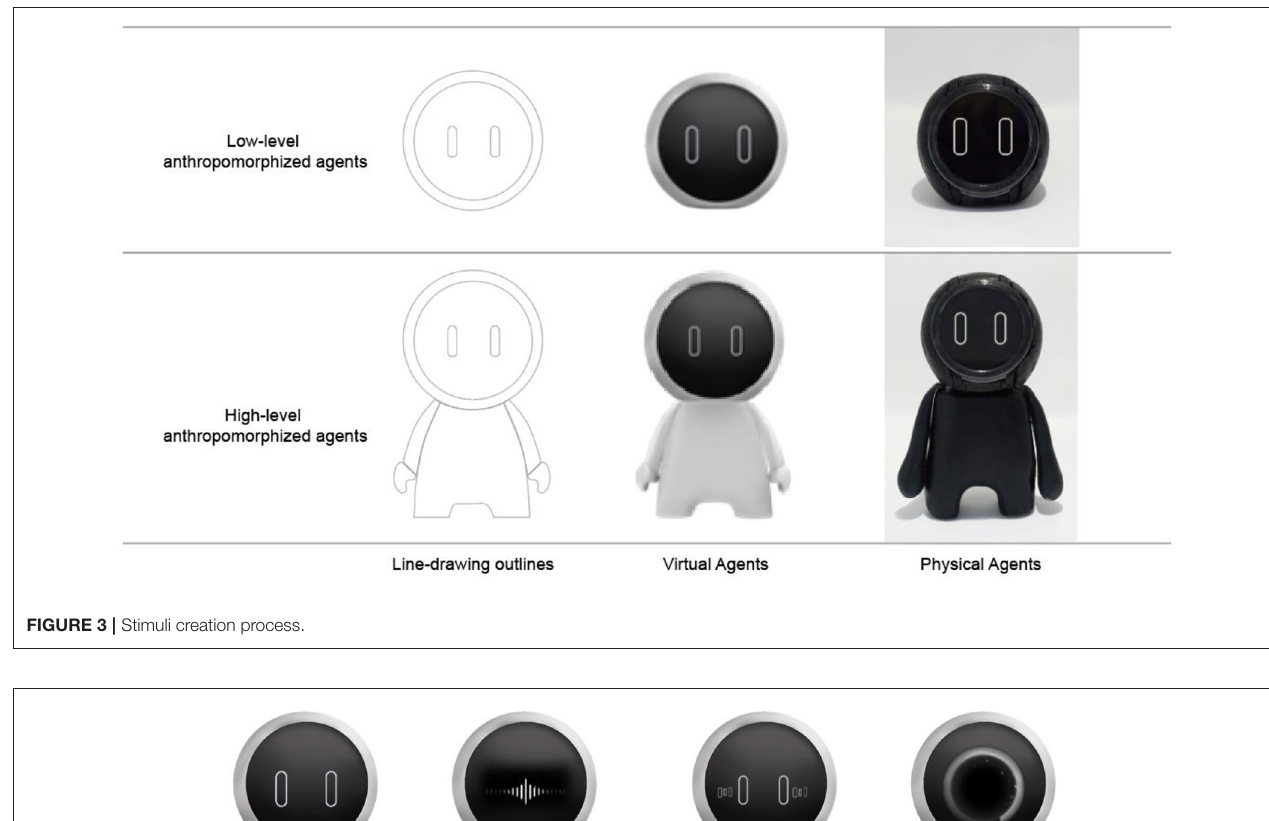
FIGURE 4 | Four facial expressions exhibited by in-vehicle agents: waiting, listening, talking, and loading, in the condition of virtual high-level anthropomorphised agents.